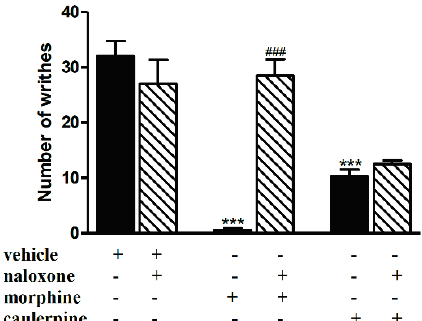
Figure 1. Effect of naloxone on the antinociceptive effect of caulerpine in the acetic acid model of nociception. Black columns: treatments alone; hatched columns: pretreatment and treatments. The results are expressed as means ± S.E.M. of six animals. (One-way ANOVA followed by Bonferroni’s test). *** p < 0.001 compared to vehicle; ### p < 0.001 compared to morphine.